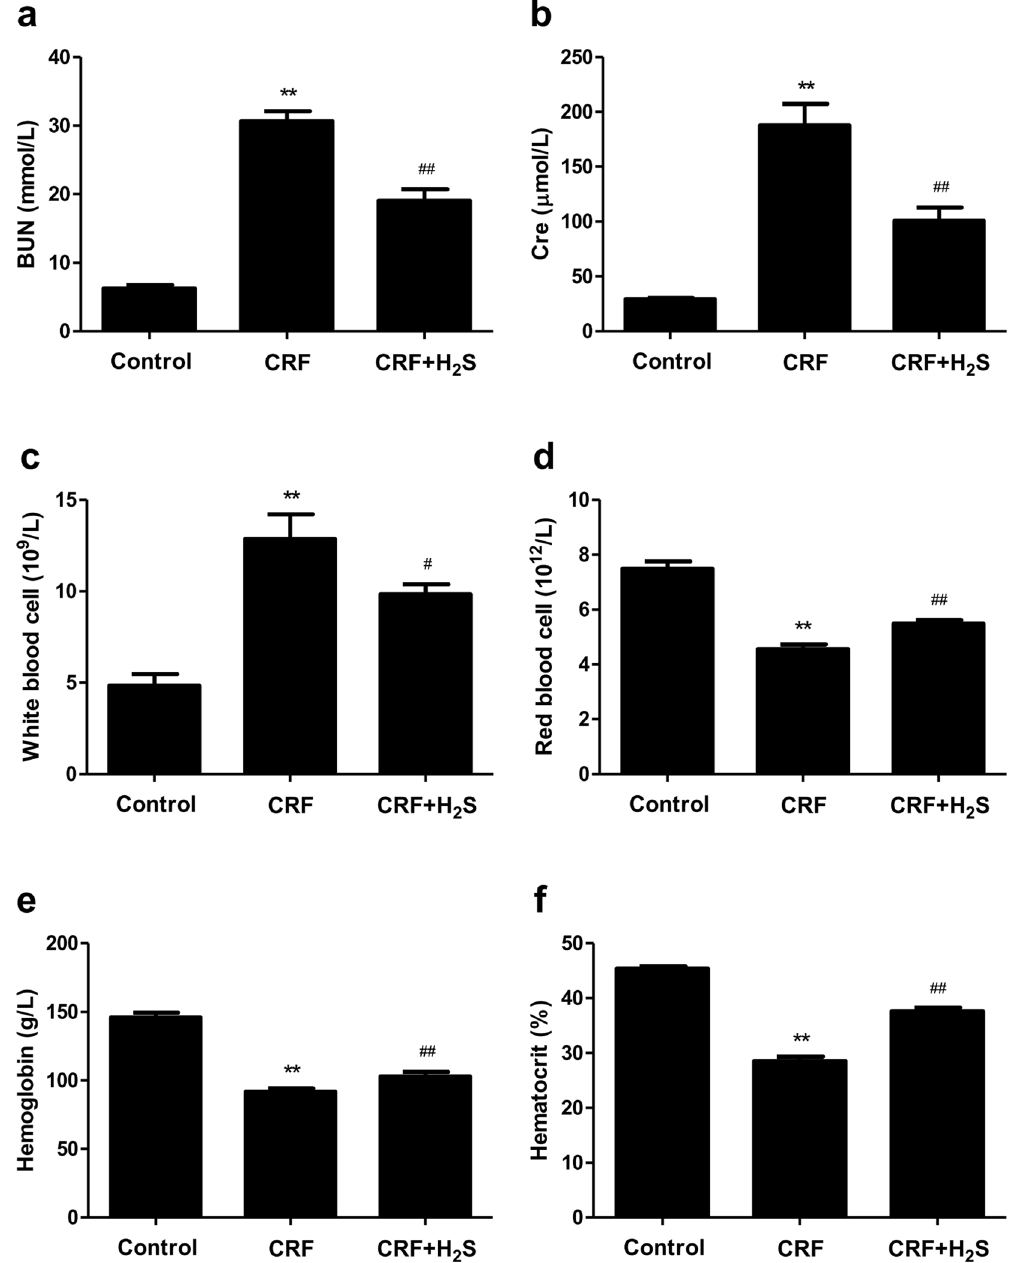
Figure 4. Effects of H 2 S on the kidney function and blood routine parameters in CRF rats. ( a ) BUN. ( b ) Cre. ( c ) White blood cell. ( d ) Red blood cell. ( e ) Hemoglobin. ( f ) Hematocrit. Values were presented as mean ± SEM (n = 8); ** P < 0.01 compared with the control group; # P < 0.05, ## P < 0.01 compared with the CRF